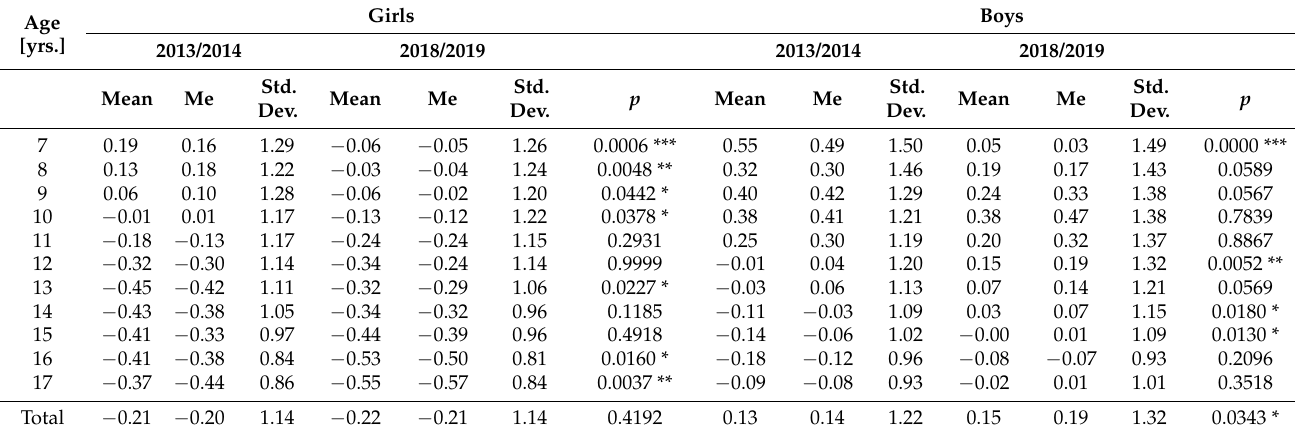
2013/2014 study. Table 2 also shows the mean values, medians, and standard deviation for the z -score of boys by age and study. The value of the Mann-Whitney test assessing the significance of differences in the z -score distribution for individual age groups between the boys from the 2013/2014 and 2018/2019 study is given. In the youngest age bands, lower z -scores were observed in the 2018/2019 study in the group of 12, 14, and 15-year-olds, significantly higher z -scores were found in the 2018/2019 study. Table 2. Z -score values with respect to age, gender, and the study—comparison between studies from 2018/2019 and 2013/2014. Girls Boys Age [yrs.] 2013/2014